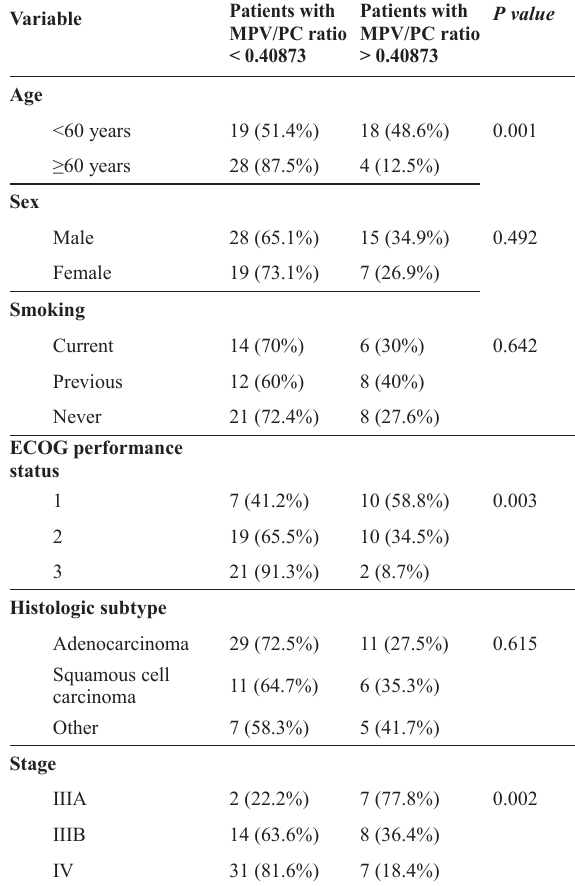
Table 2: Comparison between patients with an MPV/PC ratio above and below a cutoff value of